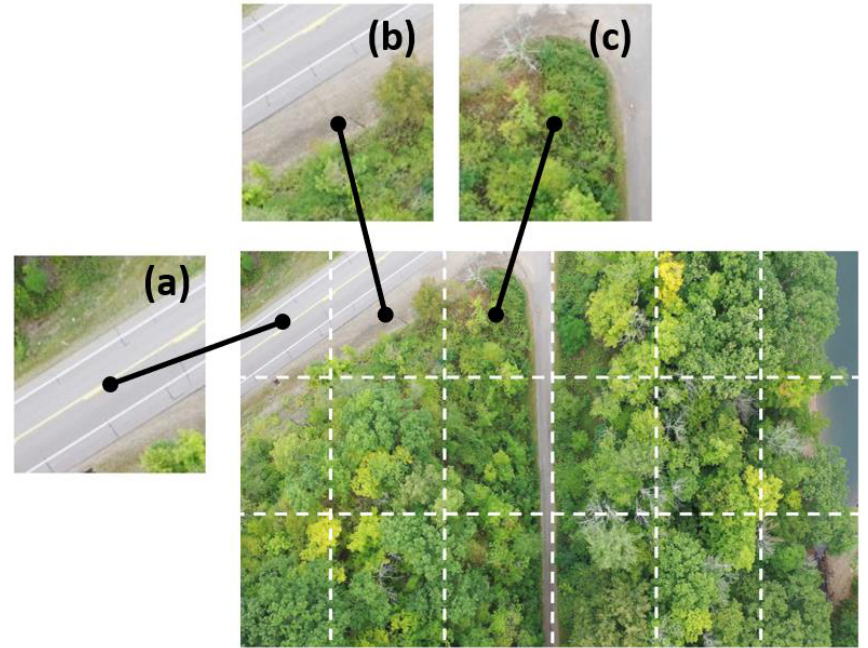
Figure 8. An illustration of patches generated from a 4K image acquired with drones. A total of 18 patches with dimensions of 640 pixels by 720 pixels were extracted from each 4K image for deep learning. Image patches ( a , b ) without declining ash trees, and image patch ( c ) has a declining or dead ash tree.